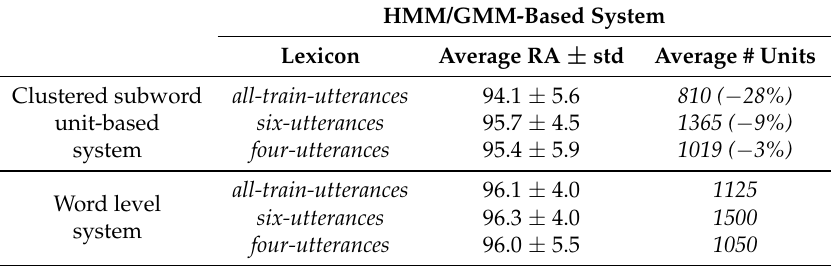
Table 4. Clustered subword unit-based and word level HMM/GMM systems results on the PhoneBook database depending on the three different setups used to infer the lexicon ( all-train-/six-/four-utterances based lexicon) using PLP cepstral